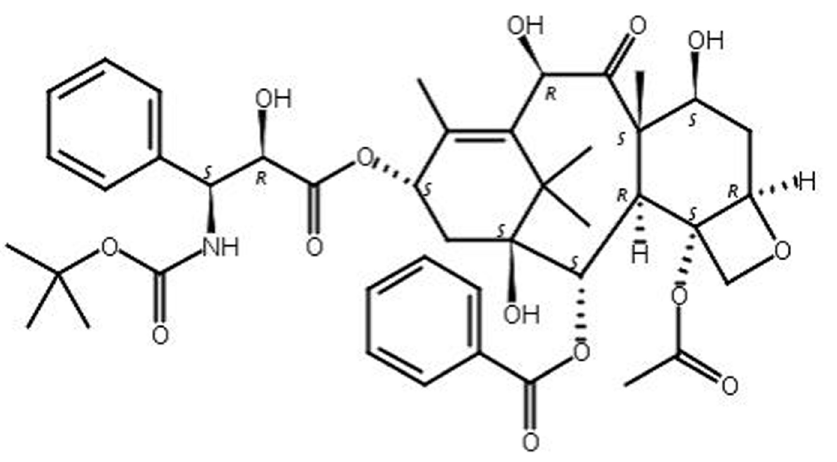
FIGURE 1 - Chemical structure of doxetaxel.